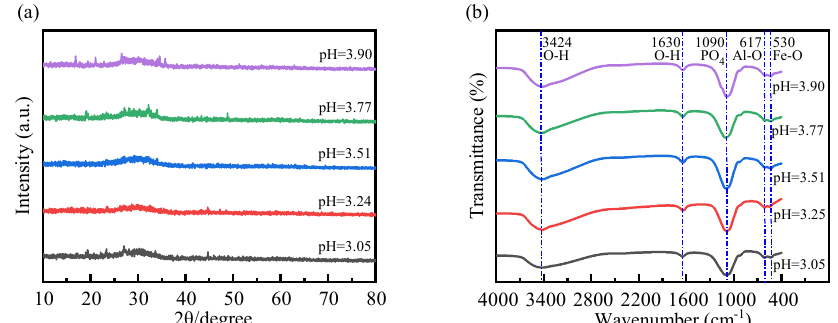
Figure 5. ( a ) X-ray diffraction (XRD) patterns and ( b ) Fourier transform infrared (FTIR) spectra of precipitate at different final pH value. (agitation rate = 400 rpm, reaction time = 5 min, and reaction temperature = 25 °C).